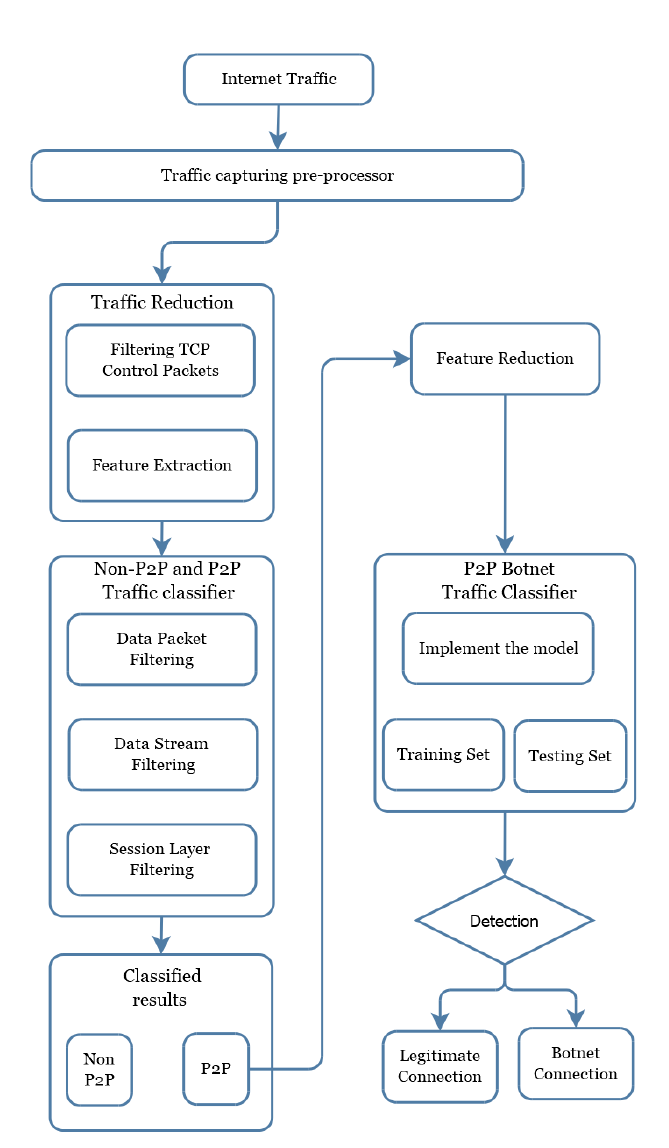
Figure 3. Architecture of the proposed